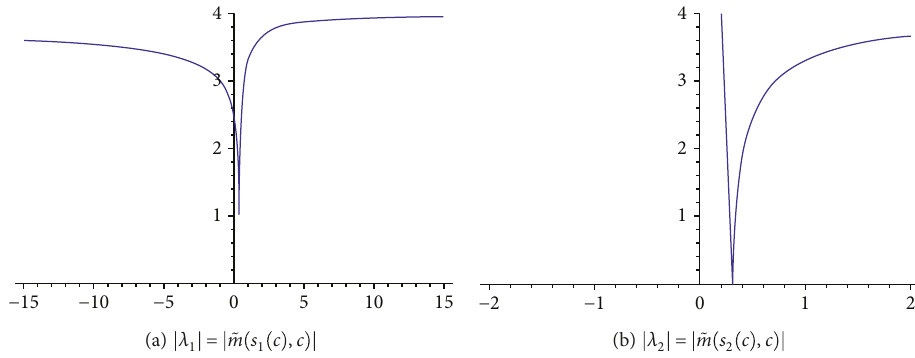
Figure 1: Absolute value of the eigenvalues λ